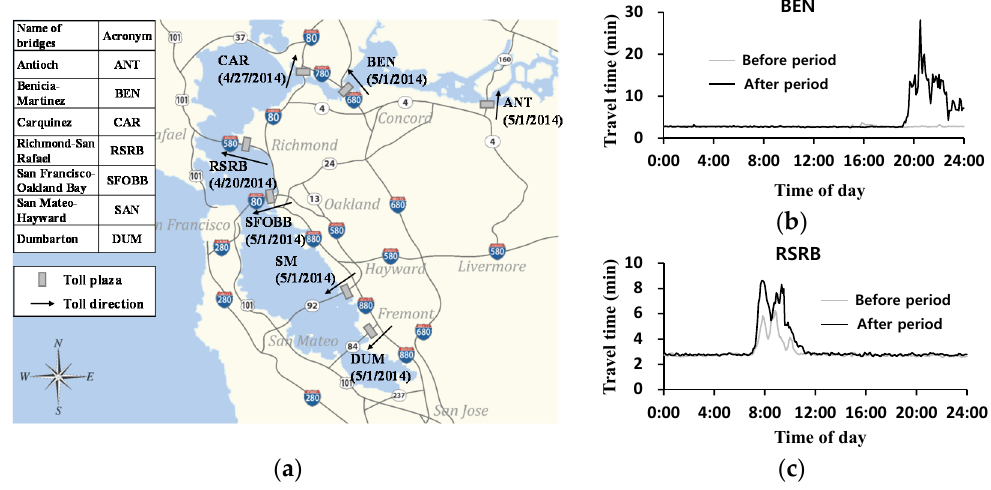
Figure 1. ( a ) Toll plazas in the San Francisco Bay Area. ( b ) and ( c ) Average travel times near bridges during weekdays before and after changes in toll plaza staffing.